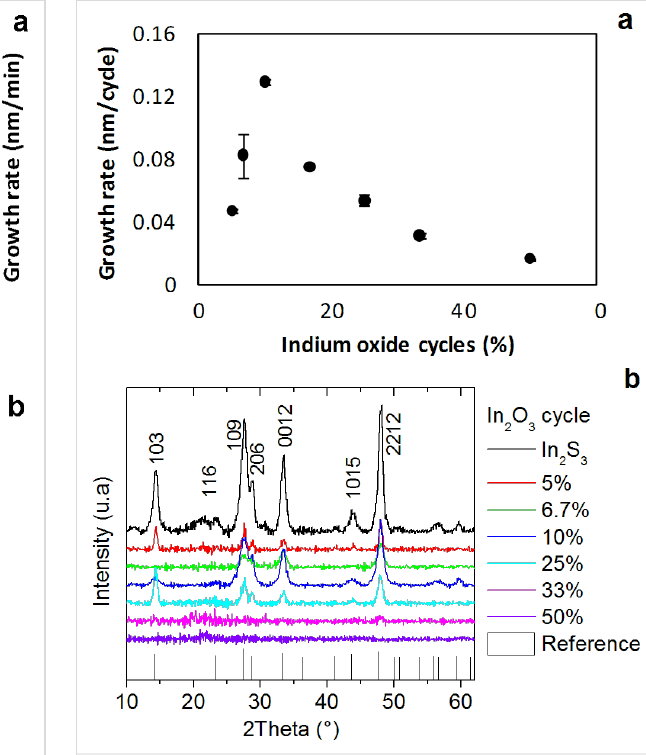
Figure 2: Influence of the number of In 2 O 3 cycles on (a) the growth rate while using H 2 O as oxygen precursor and (b) GIXRD diffrac- togram. The reference diffraction pattern for In 2 S 3 is taken from the database JCPDS 00-005-0731.